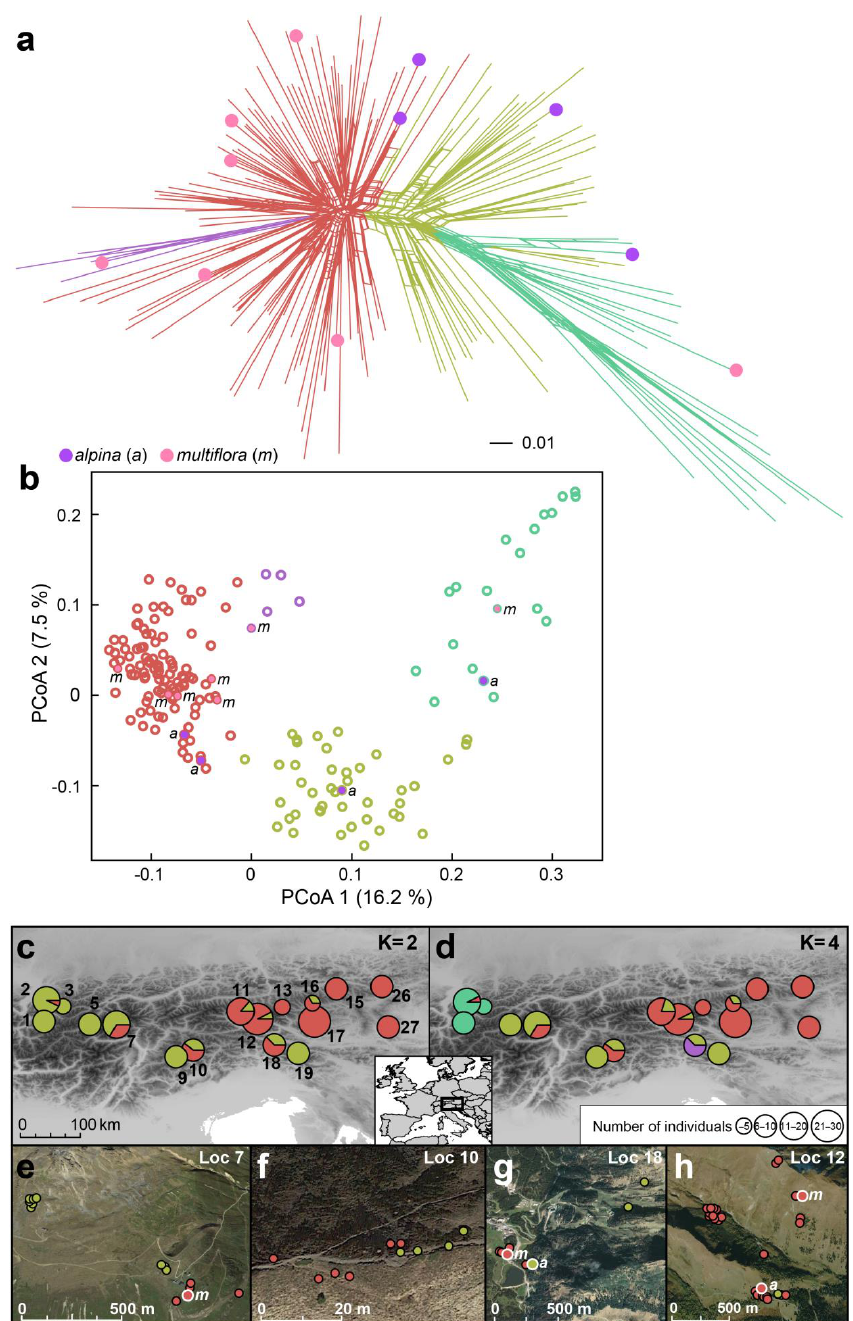
Figure 6. Genetic variation within high-elevation Eastern Alpine tetraploid populations of Luzula alpina and L. multiflora based on AFLP fingerprinting: ( a ) NeighbourNet, ( b ) Principal Coordinate Analysis scatterplot, ( c ) non-hierarchical K-means clustering for K = 2, and ( d ) K = 4. Colors in panels A and B indicate genetic clusters at K = 4. Karyologically identified individuals of L. alpina (violet filling, a ) and L. multiflora (pink filling, m ) are indicated. In panel ( c ), locality numbers correspond to Figure 3 and Table S1. In panels ( c ) and ( d ), the sizes of the pie charts correspond to the number of investigated individuals as indicated in the inset in panel ( d ). In panels ( e ) to ( h ), the distribution of individuals from four populations with presence of both clusters at K = 2 is shown at the local scale and colors correspond to the genetic clusters in ( c ); dots with white margin indicate karyotyped individuals ( a, L. alpina ; m , L. multiflora ). The locations (Loc) correspond to Figure 3 and Table S1: ( e ) Vent (Ötztaler Alpen), ( f ) Passo Giau (Dolomiti), ( g ) Nassfeld (Karnische Alpen) and ( h ) Großfragant (Hohe